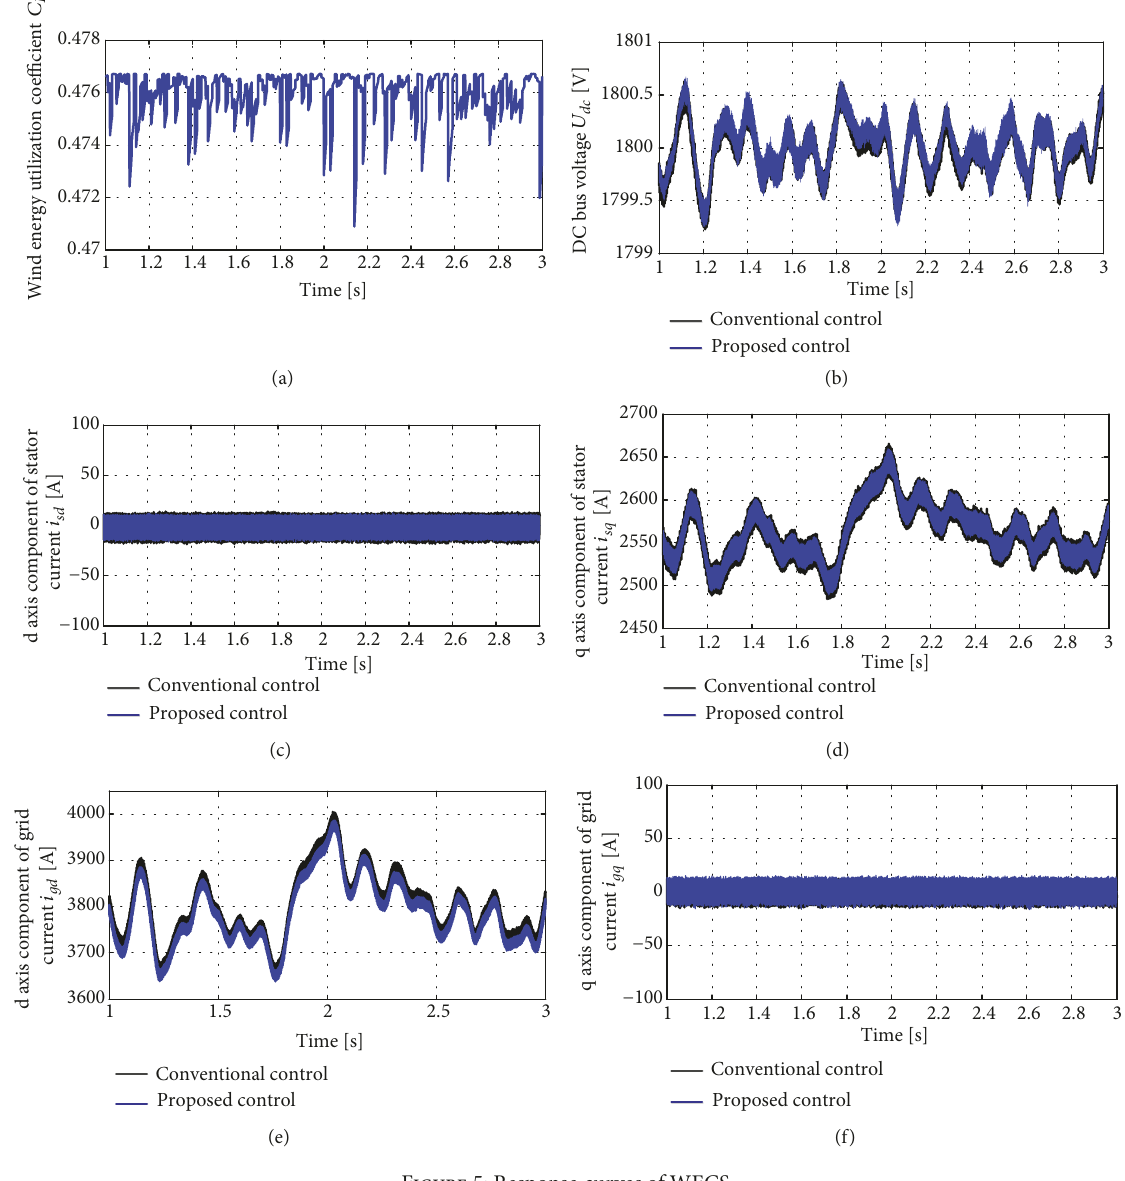
Figure 5: Response curves of